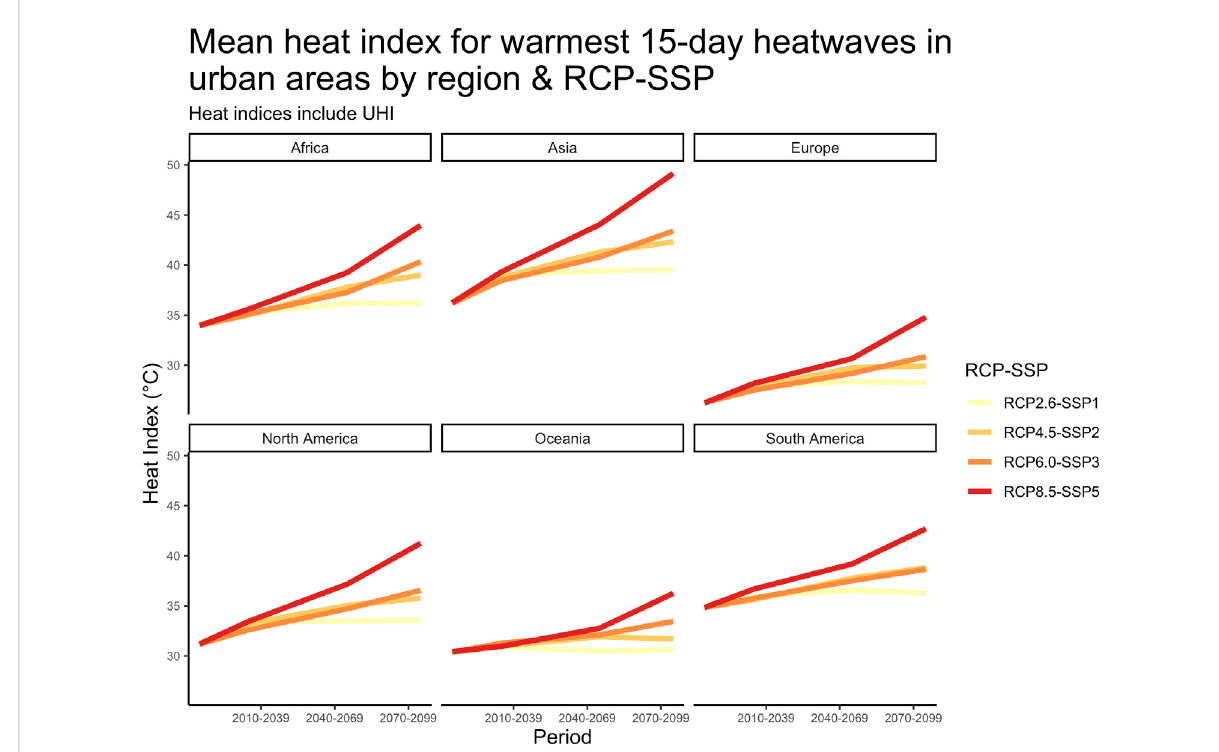
FIGURE 4 Mean heat index for warmest 15-day heatwaves in urban areas by region & RCP-SSP. This chart presents the projected changes in mean global heatindicesfor15-dayheatwavesbyRCP-SSPforallcontinentalregions.ItdemonstratesthatAsiaandAfricahavethehighest15-dayheatwaveheat indices followed closely by South America and then North